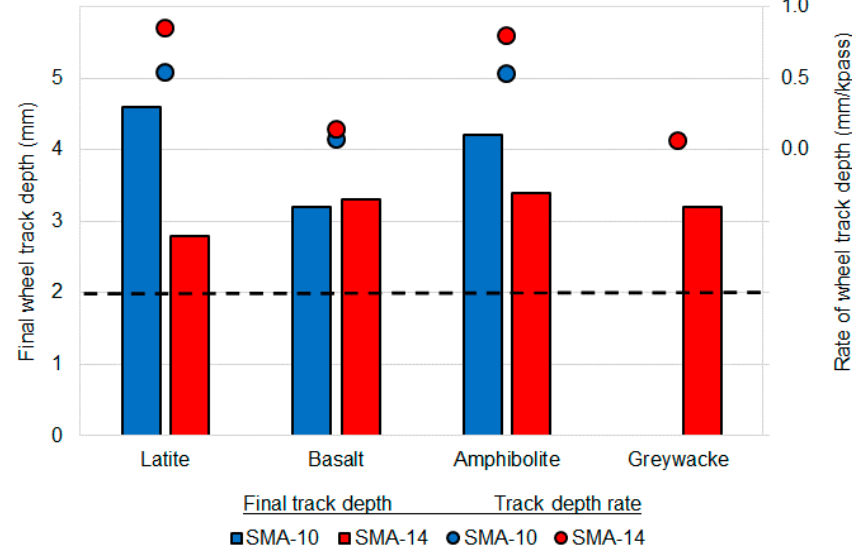
Figure 7. Average SMA wheel track depth and rate summary.